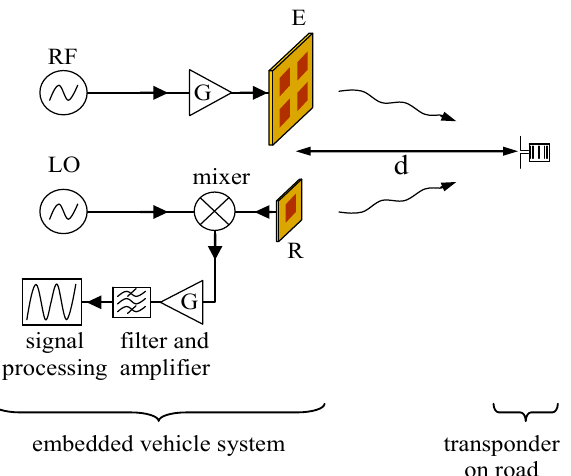
Figure 1. Experimental setup of the cooperative